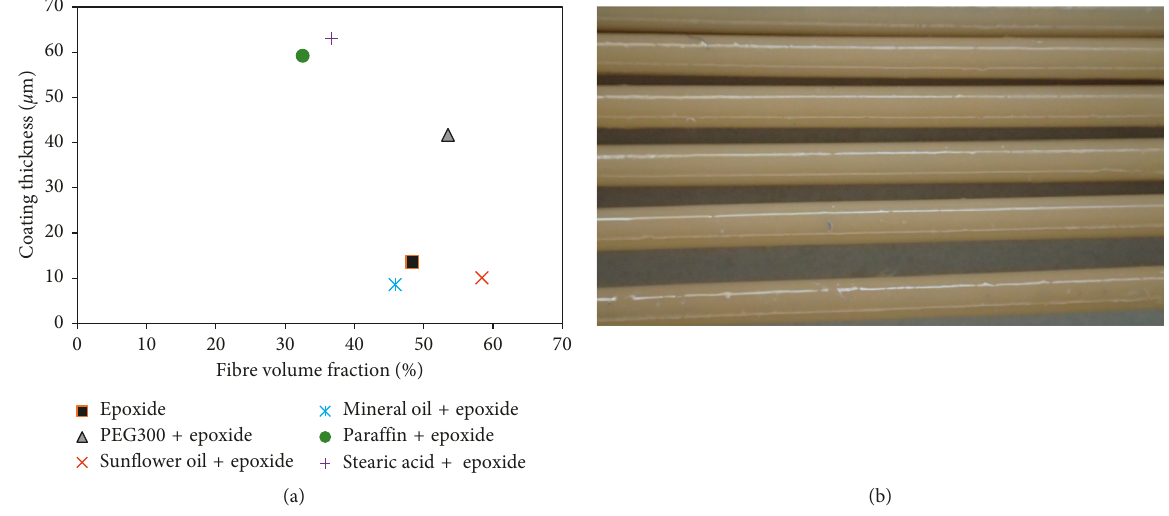
Figure 5: (a) The coating thicknesses of the various coatings used and the resultant fibre volume fractions and (b) an image of a ho- mogeneous coating with sunflower oil.